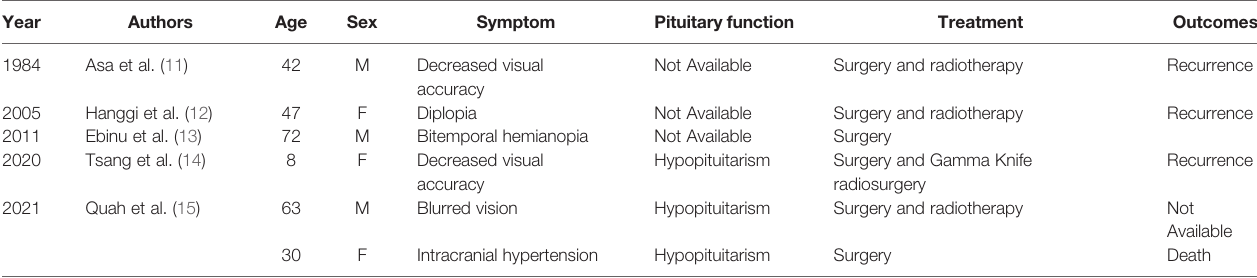
TABLE 1 | Summary of the patients ’ clinical